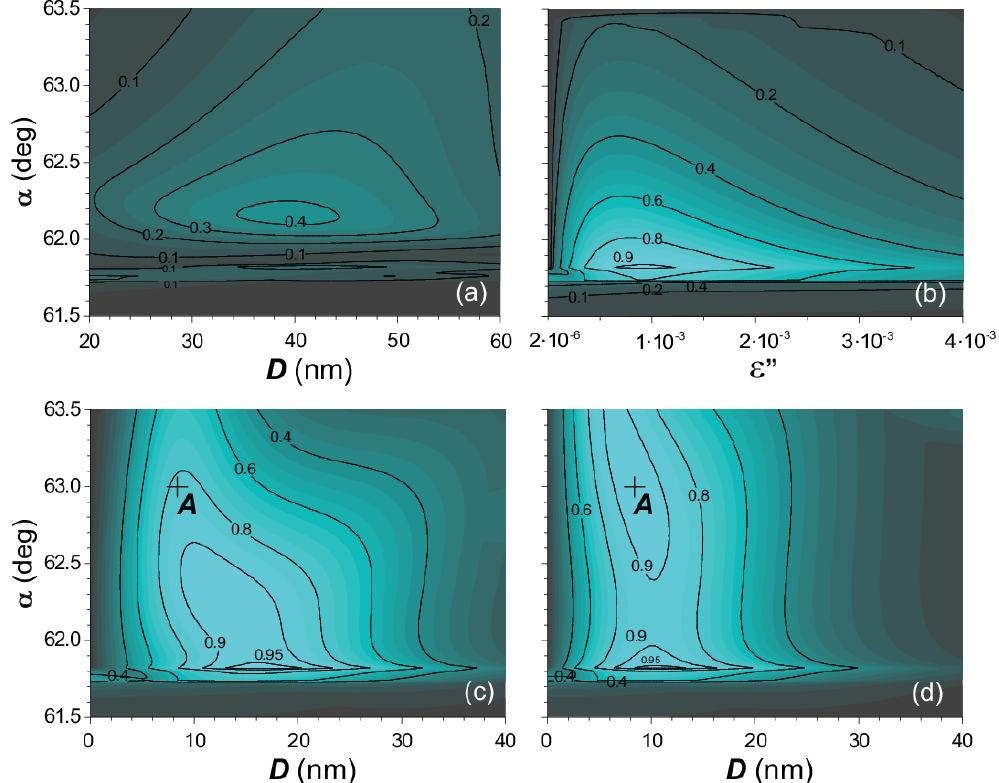
Figure 3. ( a – d ) Diagrams illustrating the performance of SPR, SWR, and two PPhC sensors, respectively. Solid contour lines show sensitivity levels (maximum ∆ R in corresponding wavelength ranges) at ∆ n = 1 × 10 − 3 , when varying parameters of the sensors. ( c , d ) PPhC sensors without and with a 50-nm-thick SiO 2 layer covering the Au layer,